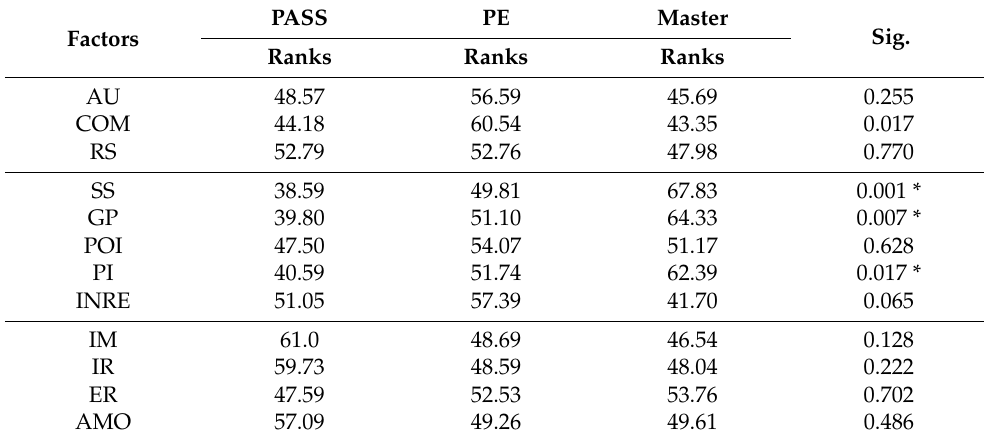
Table 3. Ranks and Kruskal–Wallis significant difference by qualification.